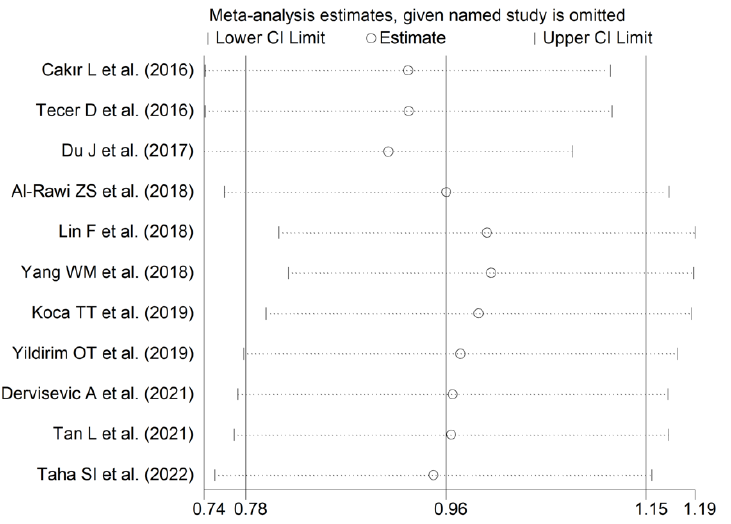
matoid arthritis. For each study, the displayed effect size (hollow circles) corresponds to an overall effect